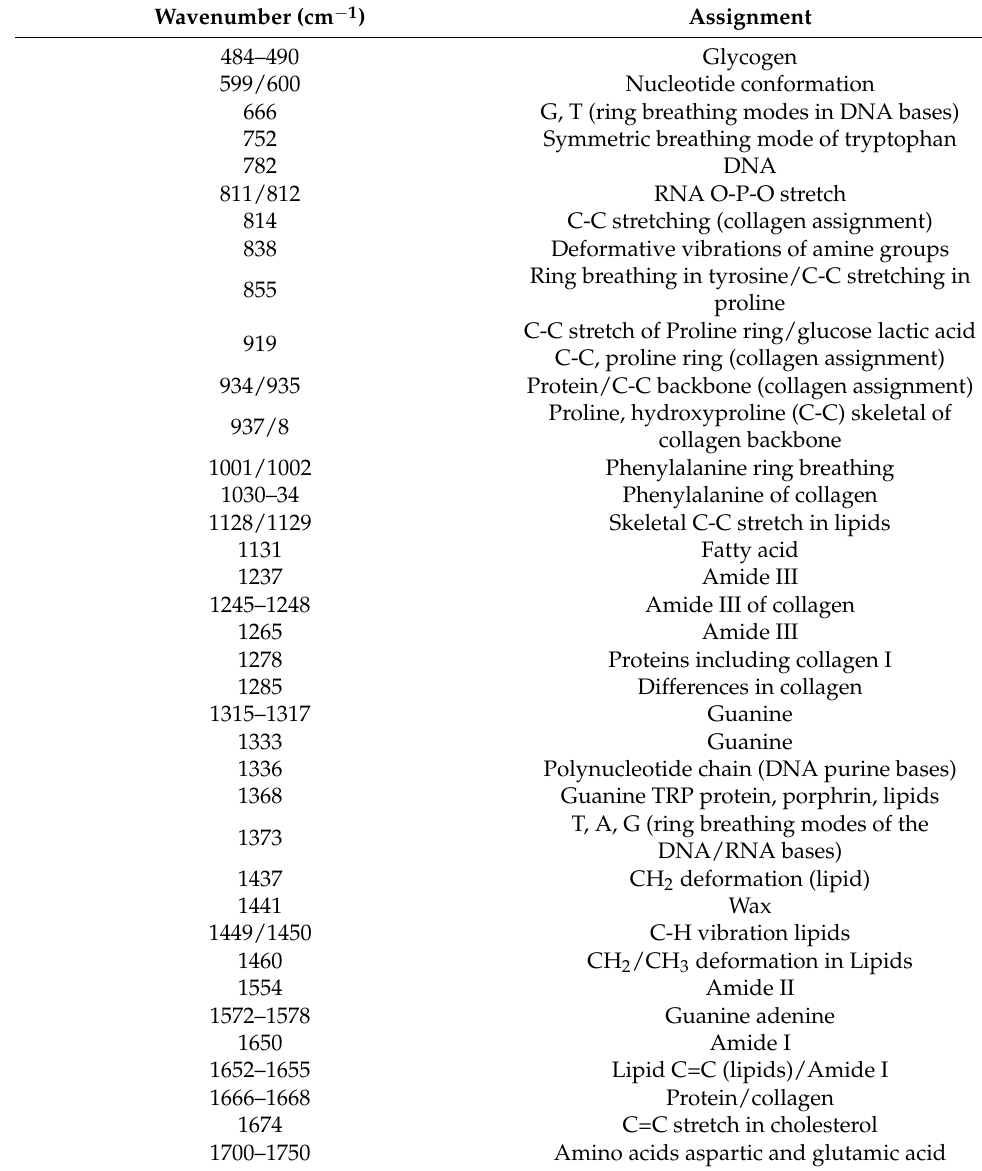
Table 1. Tentative peak assignments, adapted from Movasaghi et al. [30].